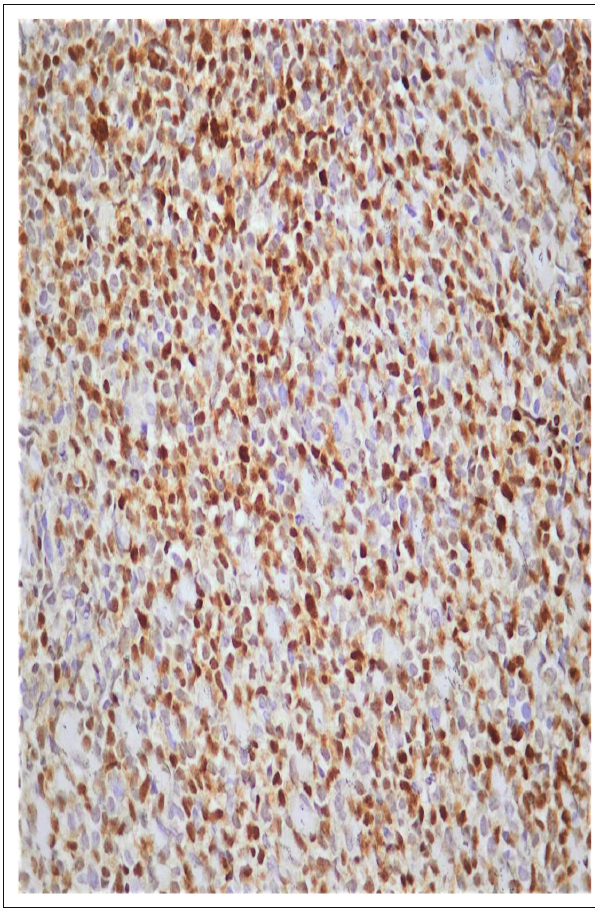
FIGURE 2: Terminal deoxynucleotidyl transferase (TdT) immunohistochemical stain of Tru-Cut biopsy of scalp mass from a 9-month-old male patient who presented to the Charlotte Maxeke Johannesburg Academic Hospital in February 2019. Image shows ~40 % positivity in the tumour. ×40 magnification